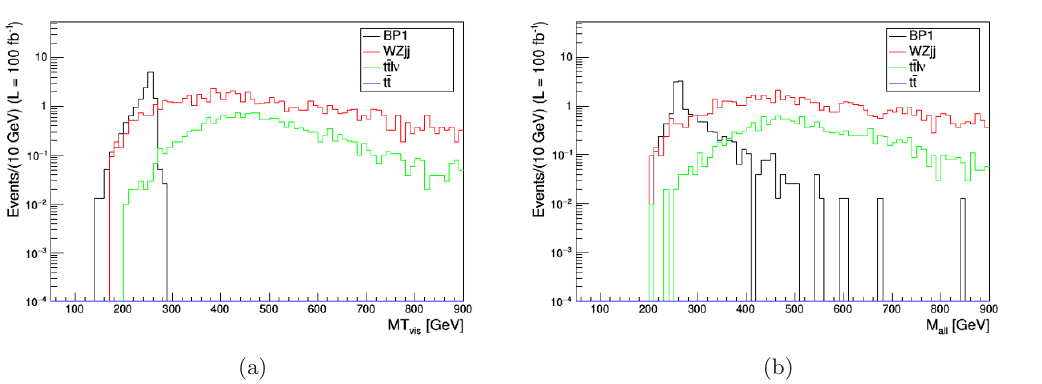
= 100 fb − 1 is assumed. L